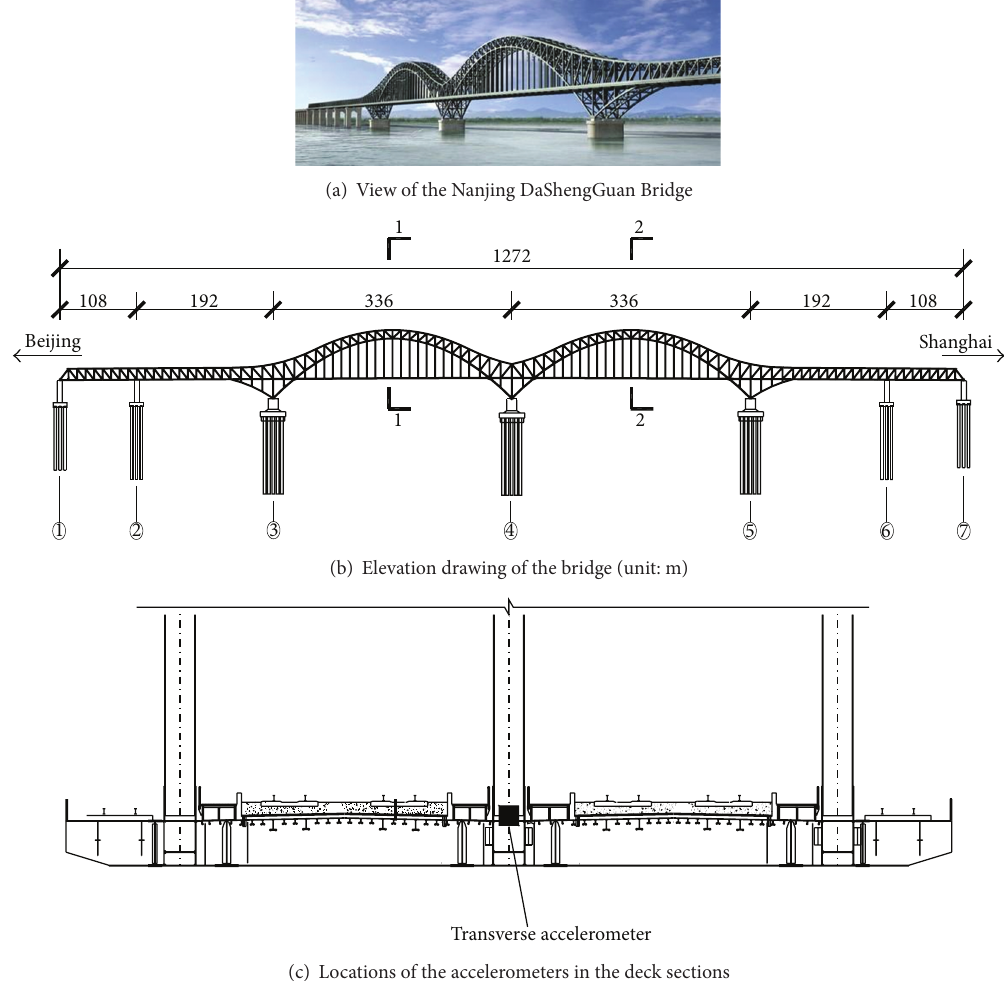
Figure 1: View of the Nanjing DaShengGuan Bridge and layout of the transverse vibration monitoring of the main girder.